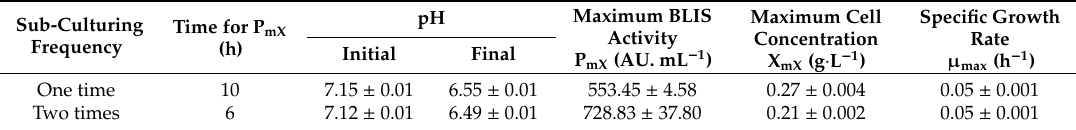
Table 6. Growth of L. lactis Gh1 and BLIS production using BHI medium, inoculated with di ff erent sub-culturing frequencies of inoculum. The inoculum was set at mid-exponential phase; at 1% ( v / v ) inoculum